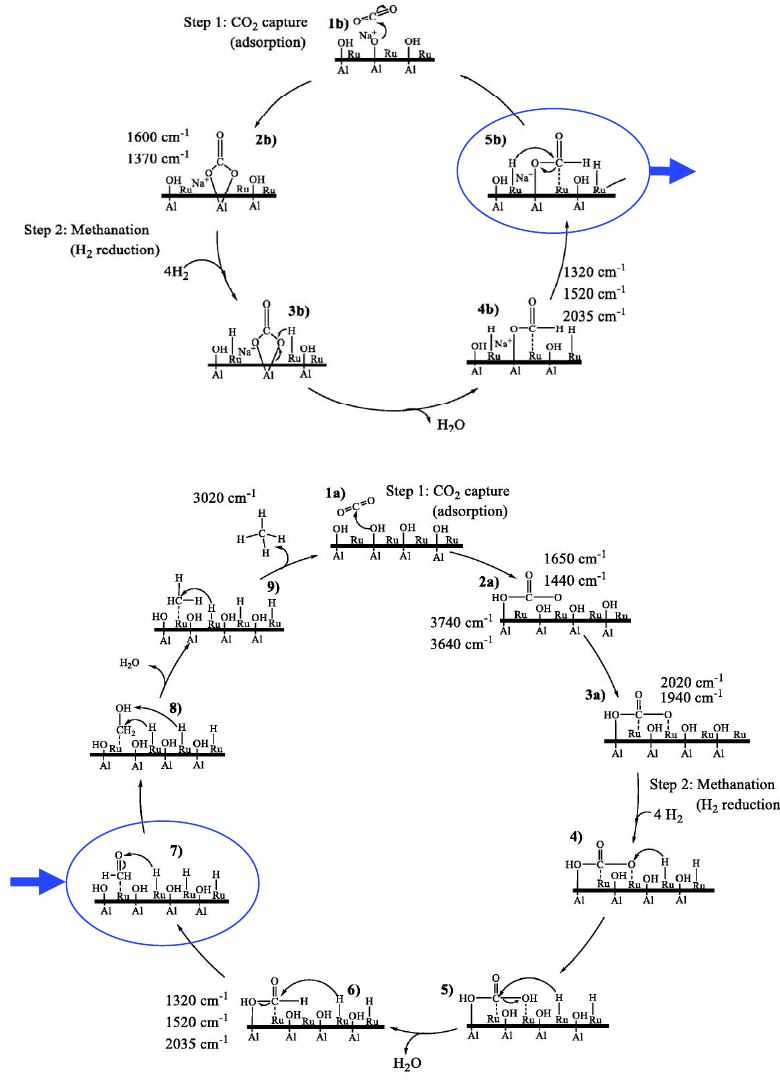
Figure 9. Proposed CO 2 methanation mechanism over 5%Ru / Al 2 O 3 (down) and extended (up and down) for over 5%Ru, 6.1%“Na 2 O” / Al 2 O 3 DFM. Reproduced with permission from ref. [116]. Copyright 2019 Elsevier.